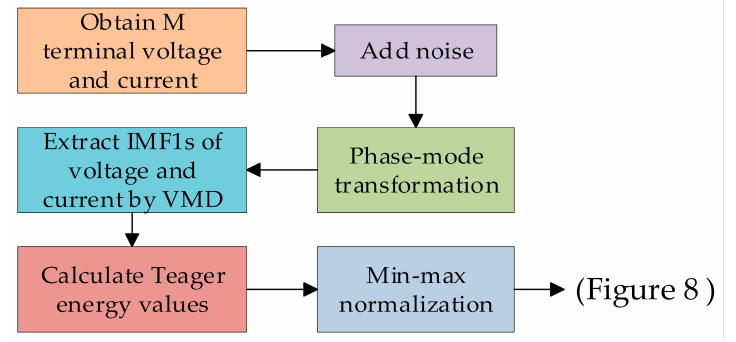
Figure 3. Process of feature